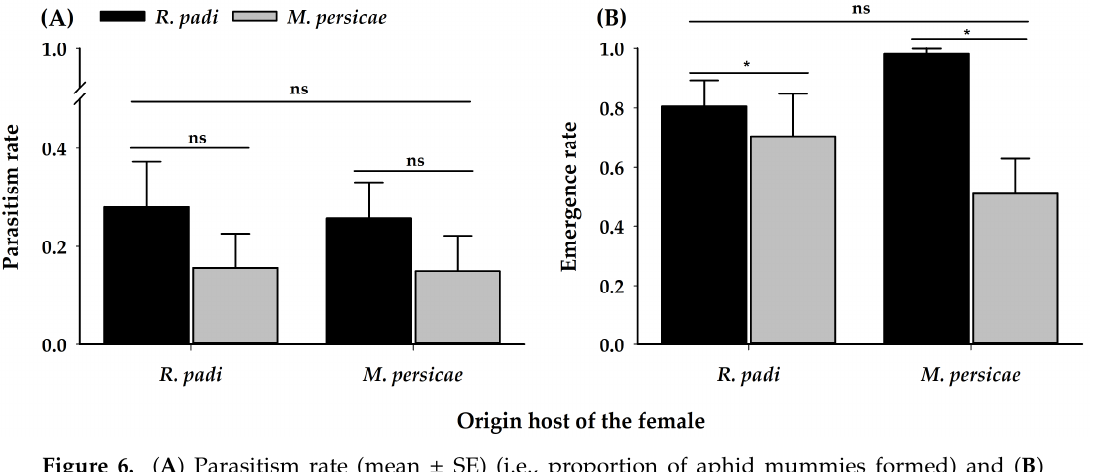
Figure 6. ( A ) Parasitism rate (mean ± SE) (i.e., proportion of aphid mummies formed) and ( B ) Emergence rate (mean ± SE) of adult progeny of A. platensis from two origins parasitizing the same aphid host. Asterisks indicate significant differences: ‘***’ p < 0.001, ‘**’ p < 0.01 ‘*’ p < 0.05, ‘ns’ non- significant p > 0.05. Black and grey bars show the chosen/tested host.